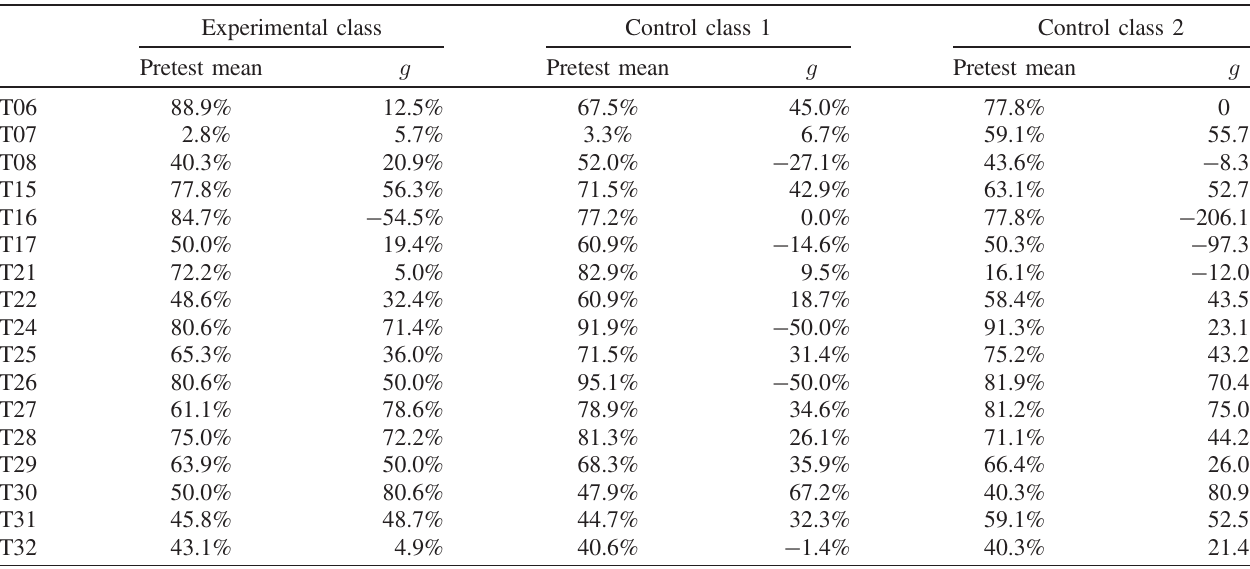
TABLE III. The average pretest score and g value.